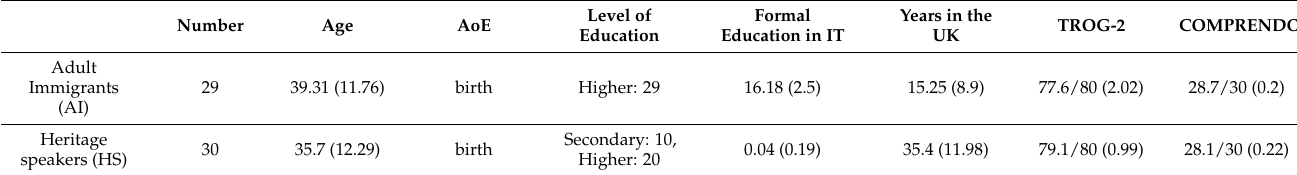
Table 2. Demographics for the participants (and standard deviations): number, age in years, age of first exposure to Italian (AoE), level of education, formal education in Italian in years, years of residence in the UK. Raw scores (and standard deviations) for background measures: TROG-2 and